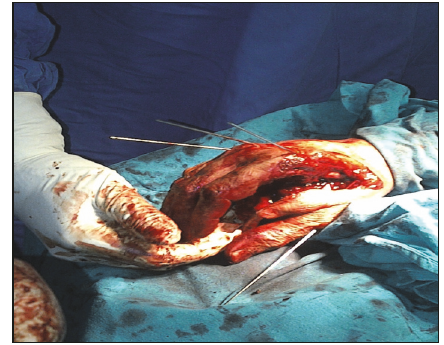
Figure 2: Intraoperative